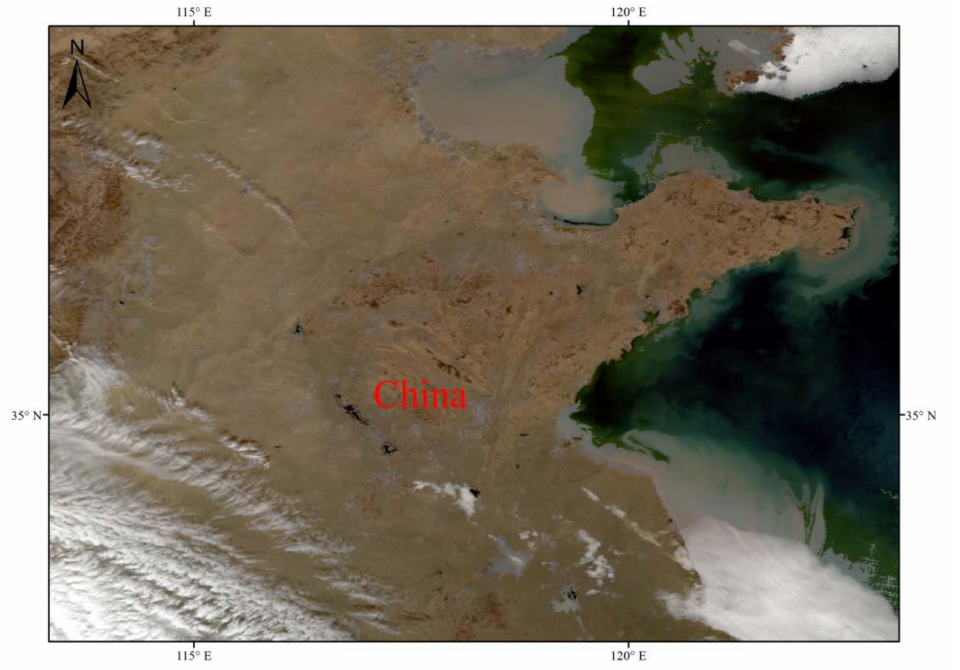
Figure 9. True-color image of East Asia on 3 February 2002.